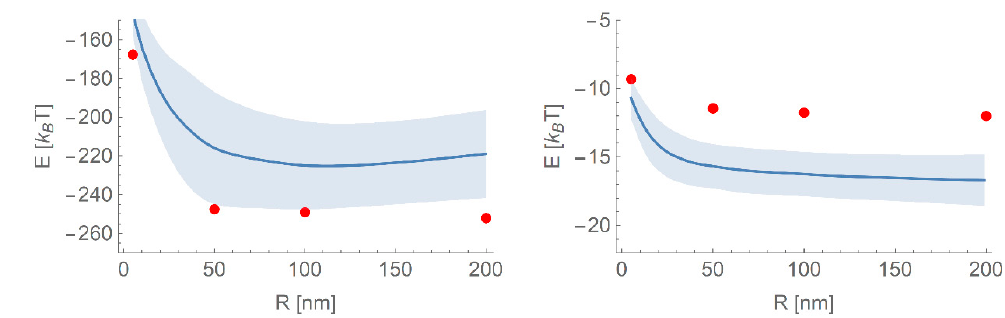
Figure 5. The predicted trends in binding energies as a function of the radius of the NP for gold ( left ) and TiO 2 ( right ) for the protein with PDB ID 1AX8. The known binding energies are shown as points, and the solid line indicates the mean of the ensemble prediction for that protein at that radius. The shaded area indicates ± one standard deviation of the ensemble predictions around the given radius.